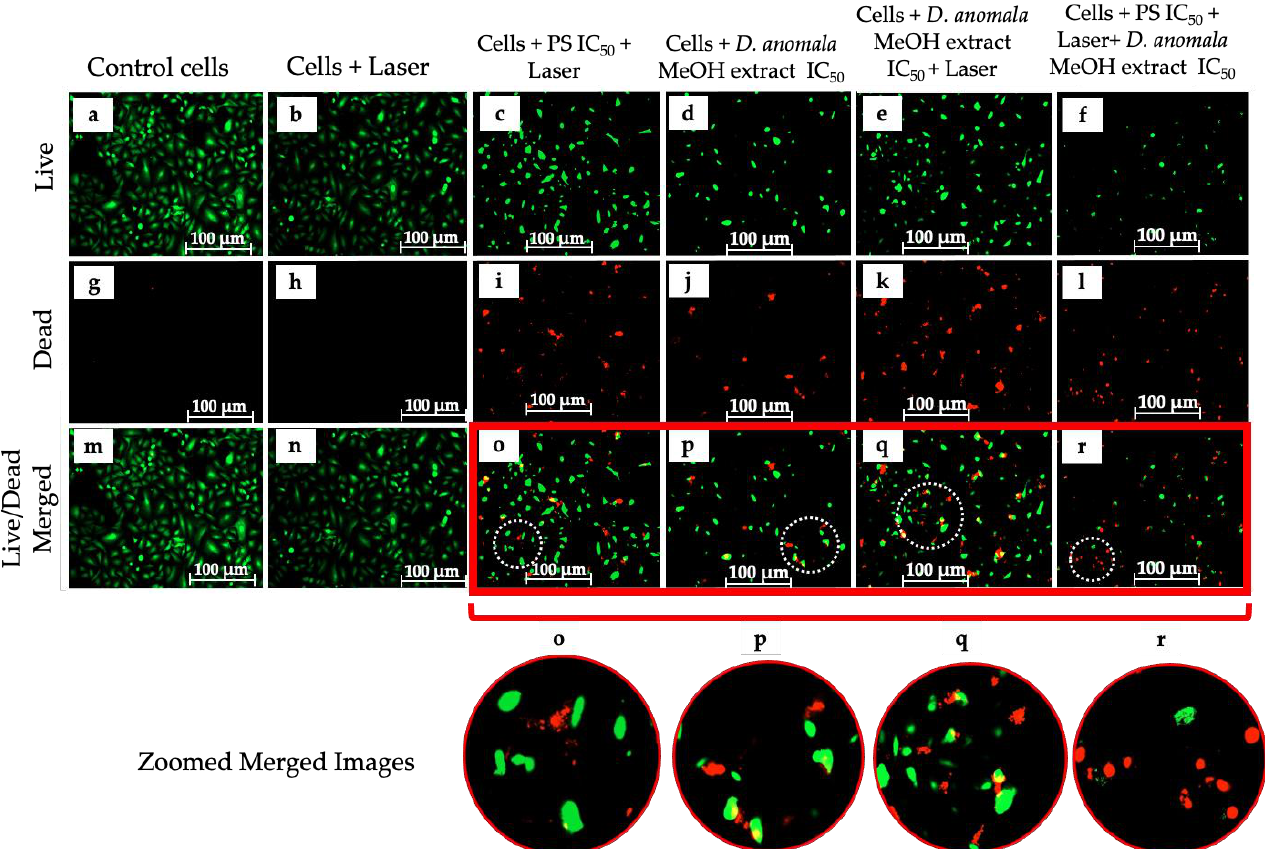
Figure 7. LIVE/DEAD TM cell viability assay. Live cells stained green ( a – f ), dead cells ( g – l ), and the ratio of live to dead cells ( m – r ). (200× magnification and scale bar: 100 μm).